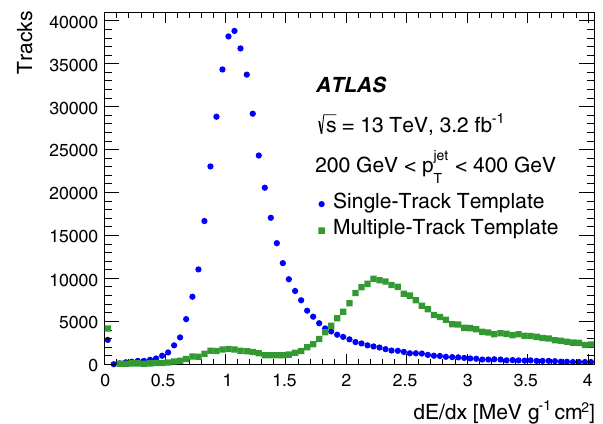
Fig. 15 Single-track and multiple-track templates for data with a jet p T in the range 200 GeV < p jet